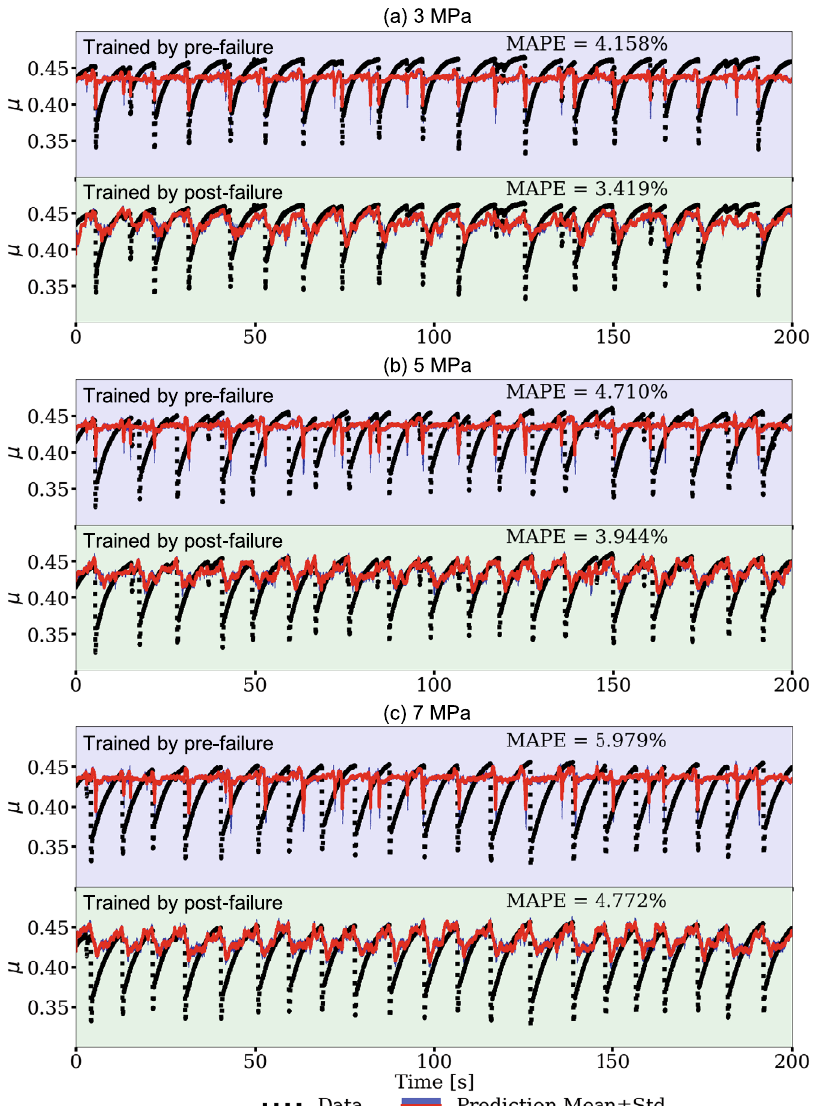
Fig. 9 Model cross-training applying limited portions of the experimental slip cycle. Two models are trained and in both cases only the latent space is trained using data from experiment p4677 applying the following criteria. One model is trained applying acoustic emission (AE) data from the post-failure portion of the slip cycle, comprising the time-period when the shear stress is increasing relatively rapidly. The second model is trained applying AE data from the pre-failure period comprising the period the fault is in a critical state and nucleating. The model encoder and decoder trained applying the simulation data remain unchanged. Friction predictions on data from the experiment p4581 testing data set for pre-failure at applied loads of 3, 5, and 7 MPa are shown in each top row of ( a – c ) shown in light blue and post-failure in each bottom row of (a, b, c) shown in light green. The shading of the panels correspond to the portion of training data highlighted in Fig. 8. The mean absolute percentage error (MAPE) is shown for each respective load level and particles con fi ned between two identical plates. Three thousand bi-dimensional particles with diameters of 1.2 and 1.6 mm were used, respectively (1500 of each). The plates had dimensions of 570 × 250 mm. At the plate interfaces semi-circular shaped “ teeth ” were placed to increase friction between plates. The particles had Young ’ s modulus and Poisson ’ s coef fi cient of 0.4 GPa and 0.4, respectively, while the plates had Young ’ s modulus and Poisson ’ s coef fi cient of 2.5 MPa and 0.49, respectively, far smaller than those used in the bi-axial shear experiment described below. Shearing velocity was 0.5 mm/s. The laboratory data 21,30 – 33 were obtained applying a bi-axial shear apparatus (Fig. 1). Laboratory experiments fail in quasi-periodic cycles of stick and slip that mimic to some degree the seismic cycle of loading and failure on tectonic faults. The apparatus comprises a central steel block that is driven at fi xed loading velocity of 10 μ m/s for the experiment. This loading imparts shear stresses within two gouge layers that are 100 mm square with an initial thickness of 5 mm. The gouge layers are located on either side of the central driving block and con fi ned by a second steel layer of 20 mm thickness. The gouge consists of monodisperse glass beads of 104 – 149 μ m diameter with Young ’ s modulus of 70 GPa and Poisson